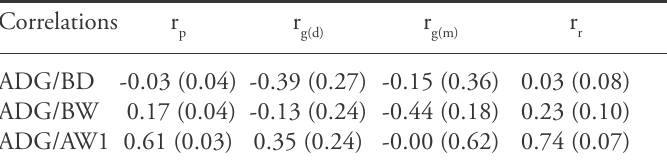
Table 6. The genetic [direct (r (r ) and residual (r p and calf birth date (BD), birth weight (BW) and calf autumn weight (AW1) in the Kutuharju reindeer herd in 1987-2011. Correlations r